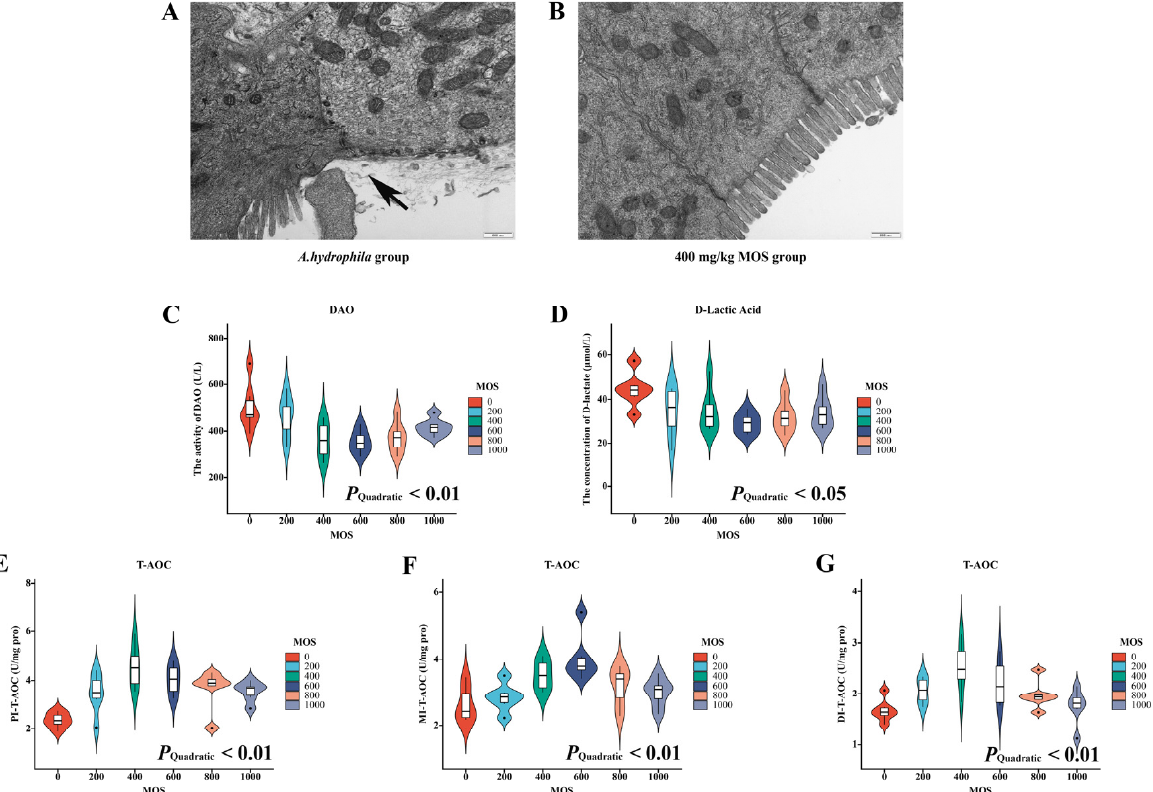
Figure 1. The effect of MOS on phenotypic indicators of intestinal structural integrity after infection with Aeromonas hydrophila . ( A , B ) Ultrastructural observation of intestine; ( C , D ) intestinal perme- ability parameters; ( E – G ) intestinal total antioxidant capacity in the PI, MI and DI. DAO: diamine oxidase (U/L); D -lactate: malondialdehyde ( µ mol/L); T-AOC: total antioxidant capacity; PI: proximal intestine; MI: middle intestine; DI: distal intestine. N = 6 for each MOS level, p -values indicate a significant quadratic dose–response relationship ( p <